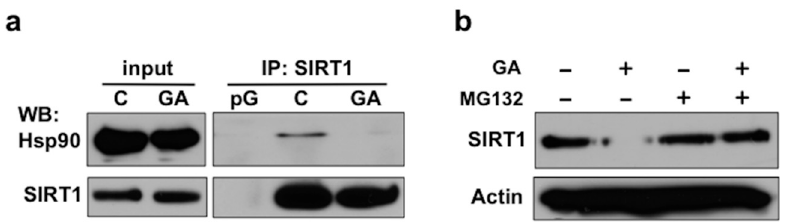
Figure 2. Disruption of the Hsp90-SIRT1 interaction leads to destabilization and proteasomal degradation of SIRT1. ( a ) SIRT1 physically interacts with Hsp90 in a GA-sensitive manner. Western blots showing the co-precipitation of Hsp90 with SIRT1 from COS-7 cells treated by 1 µ g/mL GA or vehicle for 3 h. pG, protein G control; C, control (DMSO vehicle). ( b ) GA induces destabilization and proteasomal degradation of SIRT1. Western blots of total cell lysates from cells treated by 1 µ g/mL GA and/or 5 µ M MG132 or DMSO vehicle for 20 h. Images are representatives of two experiments. 2.3. Hsp90 Is Required for SIR-2.1 Protein Stability in Caenorhabditis